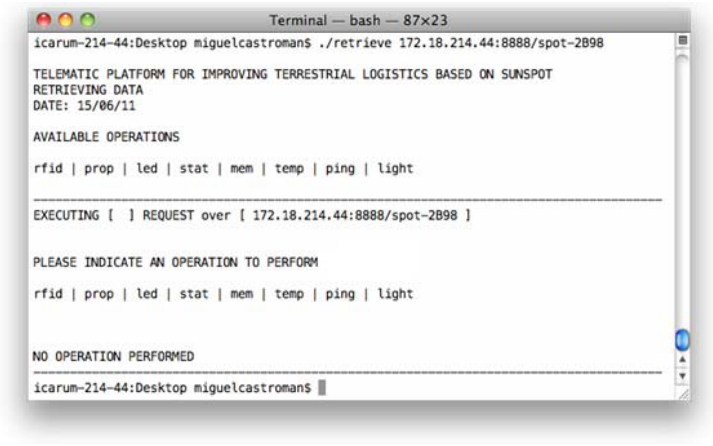
Figure 21. cURL information access example. Available